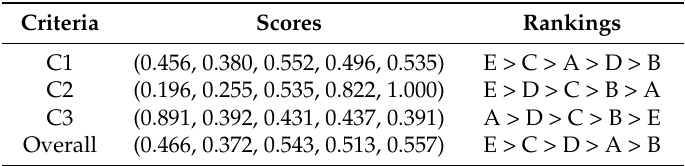
Table 11. The ranking result of alternatives on overall goal and every